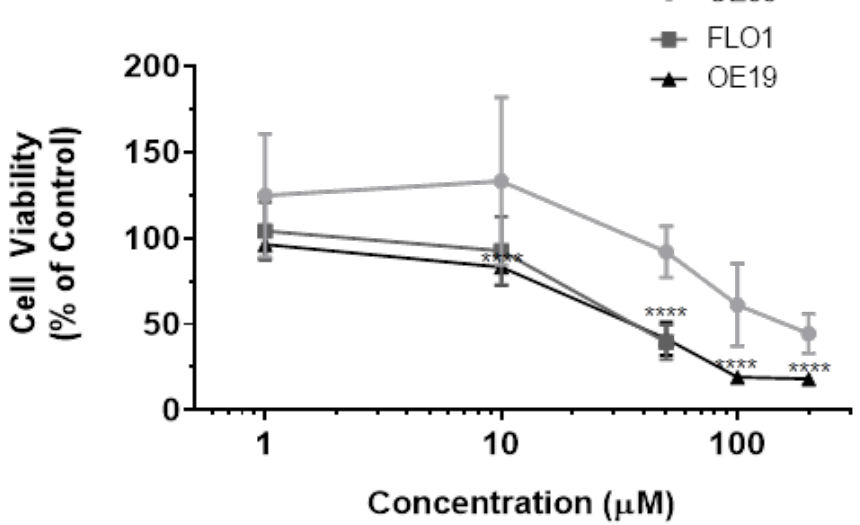
Figure 1. Cytotoxicity of resveratrol on the cells of the adenocarcinoma of the esophagus. OE33 cells (5000/well) were plated in a 96-well plate. After 24 h, cells were treated with various concentrations of resveratrol and incubated for 72 h. The cell viability was assessed by performing the CCK8 assay. The experiments were done in triplicates. The mean of three such independent experiments were calculated. OE19 cells were also treated and processed as described for OE33. Additionally, FLO-1 cells were similarly processed. The percentage of viable cells in the treatment group was calculated by considering cells in each of the control group as 100%. The data points for each cell line are the mean of three such independent experiments. A one-way ANOVA was used using Dunnett’s mul- tiple comparisons test with the Alpha value set to 0.05. **** FLO-1: p -value < 0.0001 from 25 μ M onwards. OE19: p -value < 0.0001 from 10 μ M onwards, OE33: significant change seen from 200 μ M onwards. 3.2. Molecular Analysis of R esveratrol’s Action Reveals the Impact on the Programmed Cell Death Pathway in the Three Esophageal Adenocarcinoma Cell Systems (OE33, OE19 and FLO- 1) Studied On observing cell death caused by resveratrol, we proceeded to understand its mechanism of action. Programmed cell death pathway is one of the major pathways induced by anticancer agents. To assess if programmed cell death pathway was induced by resveratrol in each of the cell system, we opted to perform flow cytometric analysis, because this assay is reported to be a sensitive assay. Annexin V Muse flow cytometric assay was performed by treating OE33 cells with the IC 50 concentration of resveratrol (100 μM) for 72 h and compared with the control group. Representative scatter plots of three independent trials of the control group and the treated group are shown in Figure 2A,B, respectively. The profiles (% gated) of the treated group versus the control group showed an increase in apoptotic population in the treated group, Figure 2C. Similarly, OE19 and FLO-1 cells were treated with resveratrol at an IC 50 concentration of 50 and 40 μM , respectively, and analyzed by Annexin V Muse flow cytometric analysis. For OE19 cells, representative scatter plots of four independent trials of the control group and the treated group are shown in Figure 2D,E, respectively. The profiles of the treated group versus the control group also showed an increase in apoptotic population in the treated group, Figure 2F. For FLO-1 cells, representative scatter plot of four independent trials of the flow cytometric assay of the control and treated cells are shown in Figure 2G,H. The profiles of the control group versus the treated group showed an increase in apoptotic cells, as seen in Figure 2I. The studies showed that on the administration of resveratrol, there was a significant increase in the total number of apoptotic cells, above 4-fold when compared to